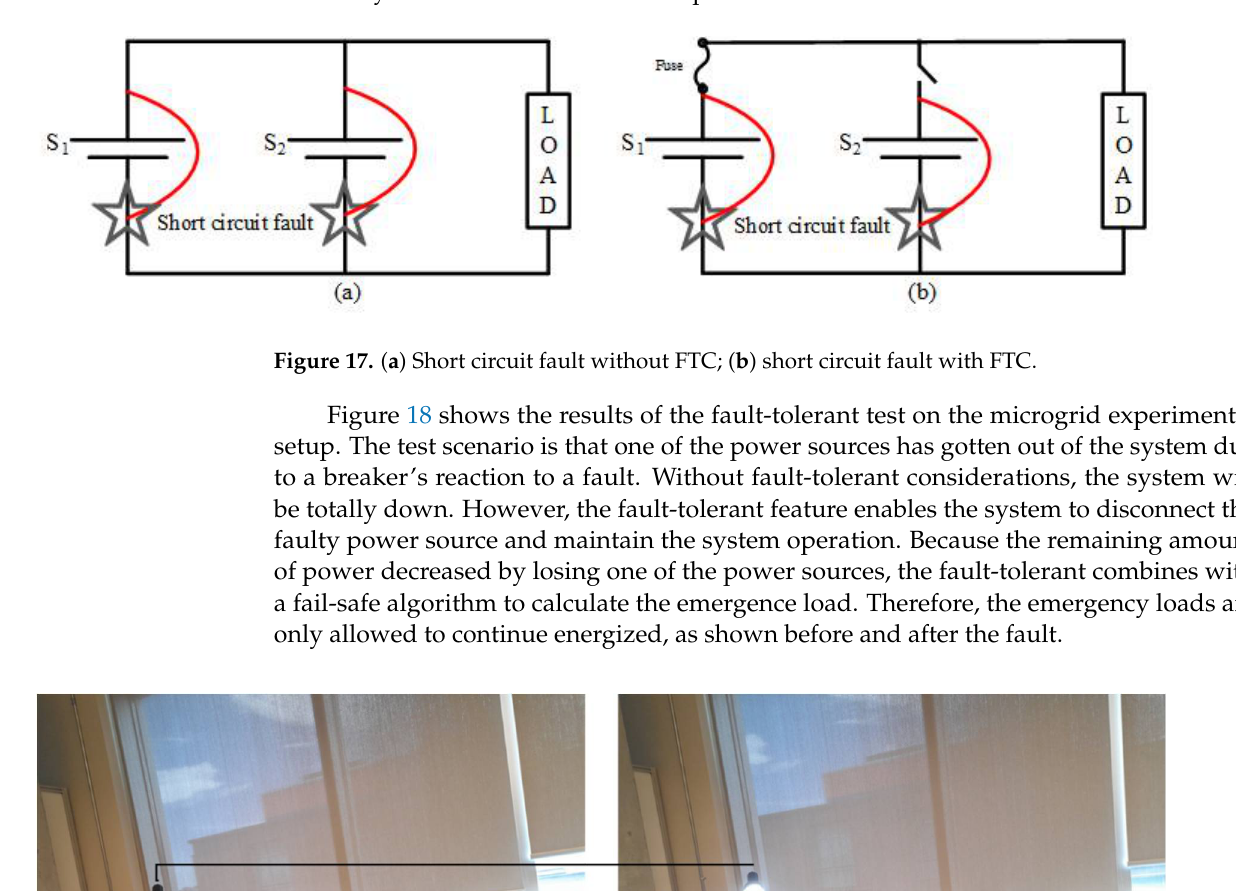
Figure 16. ( a ) Normal operation; ( b ) operation during fault condition.